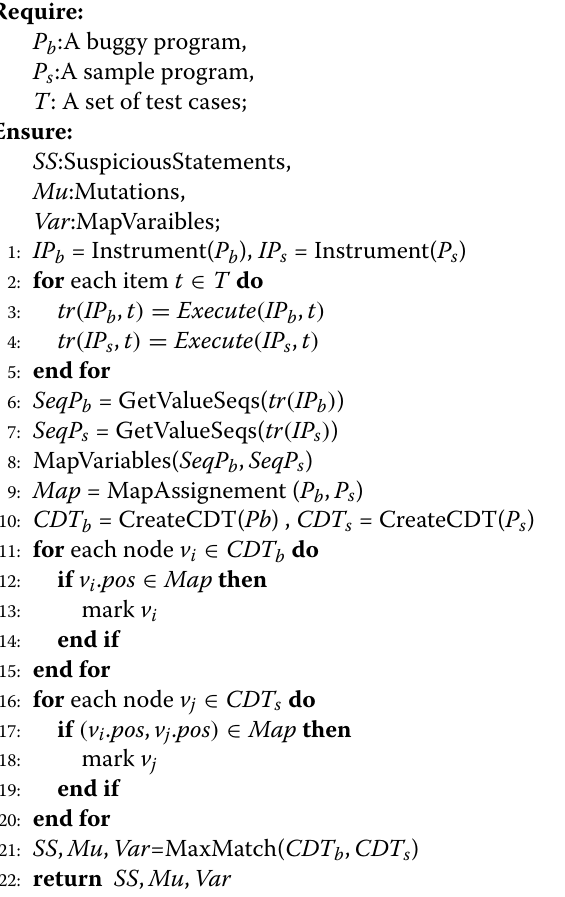
Algorithm 2 Fault localization by analyzing failure